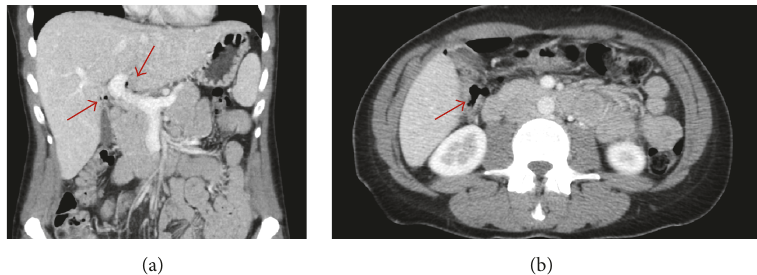
Figure 2: Coronal (a) and transverse (b) views of the CT of the abdomen and pelvis, read as “free intraperitoneal air, findings suggestive of a perforated viscus. There is free air around the porta hepatis which would favor an upper GI source.” Arrows in (a) refer to coronal view of free air around the porta hepatis and in (b) to transverse view of free air around porta